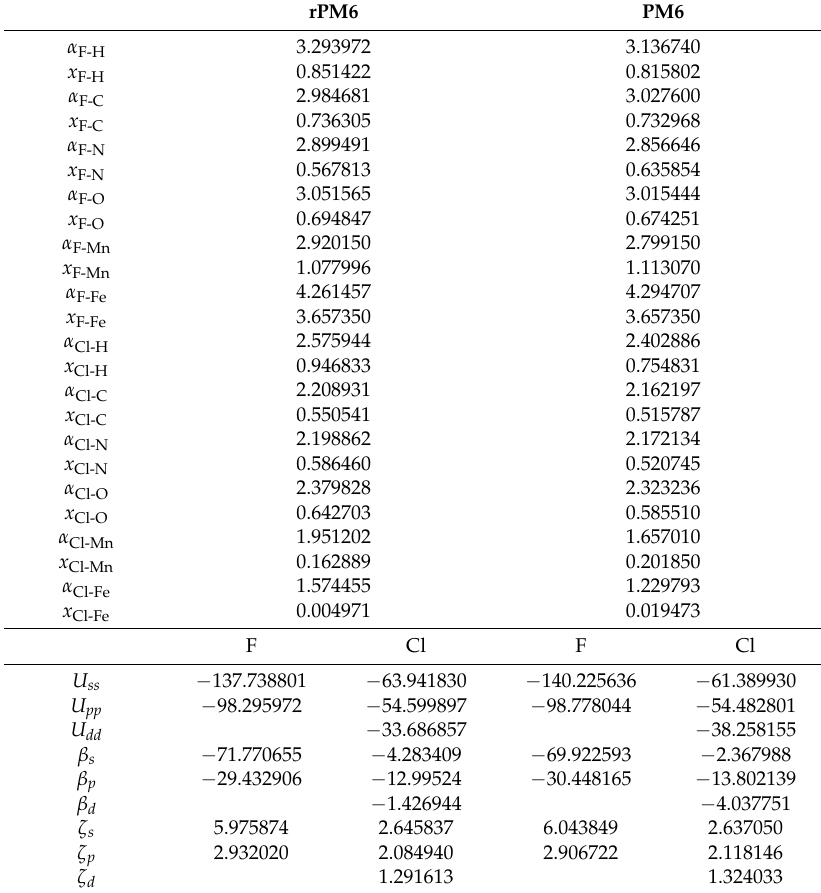
Table 1. Comparison of parameters a between rPM6 and PM6 b